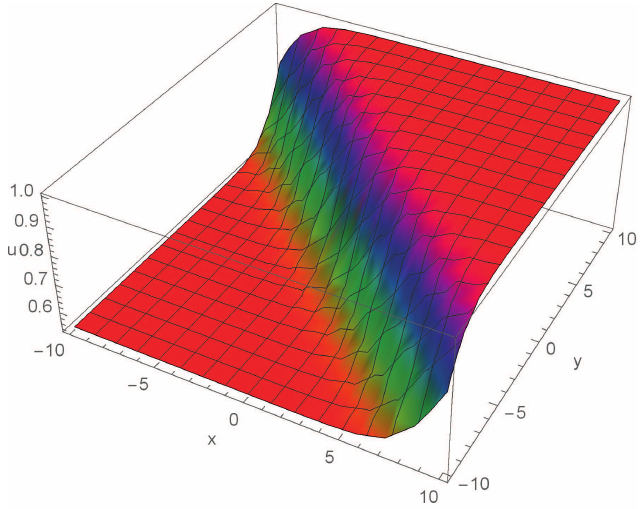
Fig. 1 The surface plot of the PIA solution u 4 ( x , y , t ) for ℜ = 100 and t = 0 . 1 when α = 0 . 75